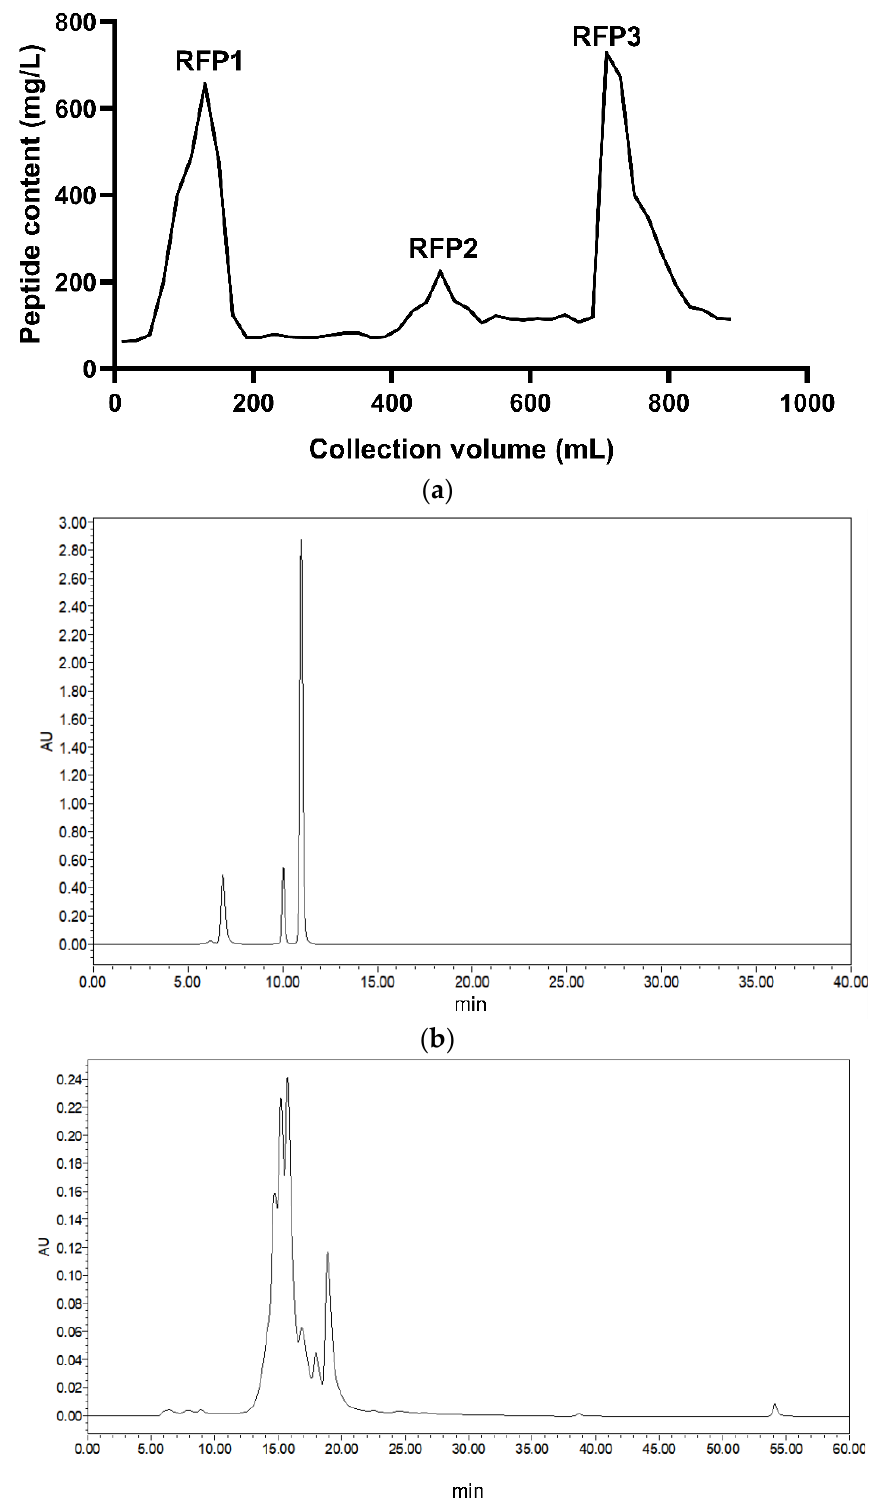
Figure 1. Purification of peptides from fermentation broth: ( a ) Purification curves of rice fermenta- tion peptides in chromatography column; ( b ) elution curves of RP − HPLC for standard samples; and ( c ) elution curves of RP − HPLC for RFP.